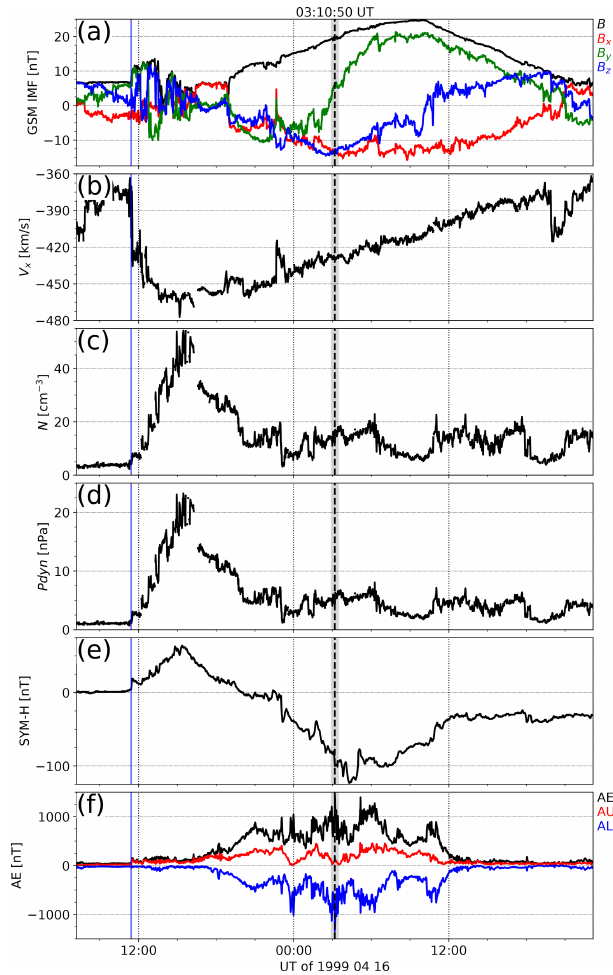
Figure 11. Data in a format similar to Fig. 6 ± 20h around the event on 17 April 1999 at 03:10:50UT. The vertical blue line indicates a SC at